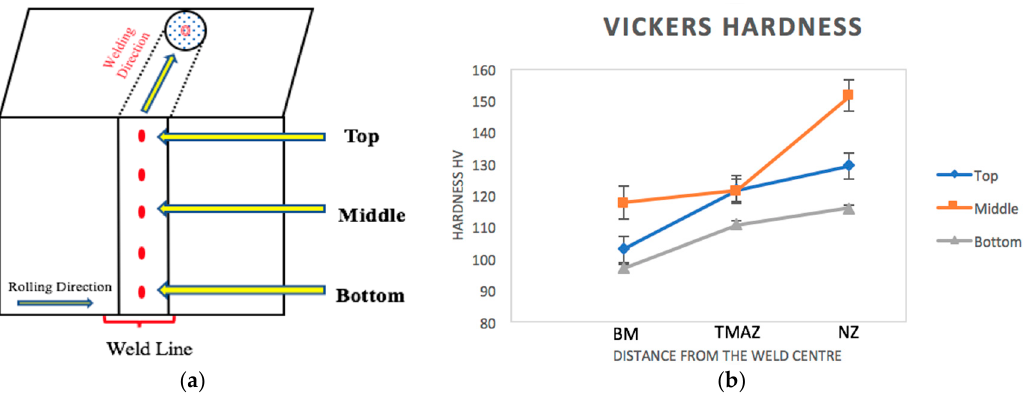
Figure 4. ( a ) Schematic illustration showing two plates of Al 7075 alloy welded by FSW; ( b ) hardness gradient for different points of the material; values are the average of three readings.